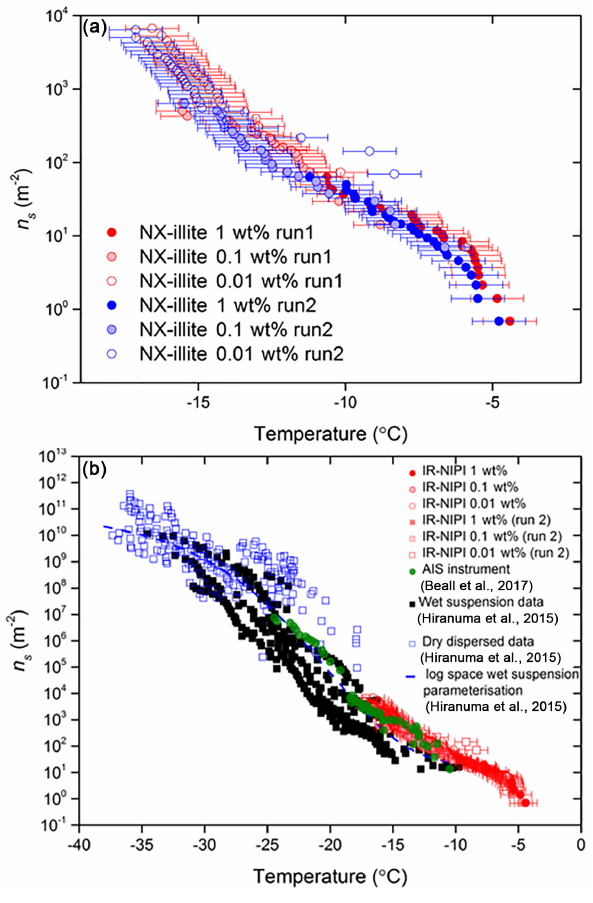
Figure 6. Comparison of nucleation induced by feldspar chips in the IR-NIPI and µL-NIPI instruments. (a) The fraction frozen curves for single feldspar particles per droplet in both the µL-NIPI (using 1µL droplets) and IR-NIPI (using 50µL droplets) experiments. The error bars indicate the error in temperature measurement on both in- struments. (b) The freezing temperature for the individual feldspar chips as measured by the IR-NIPI and µL-NIPI instruments.